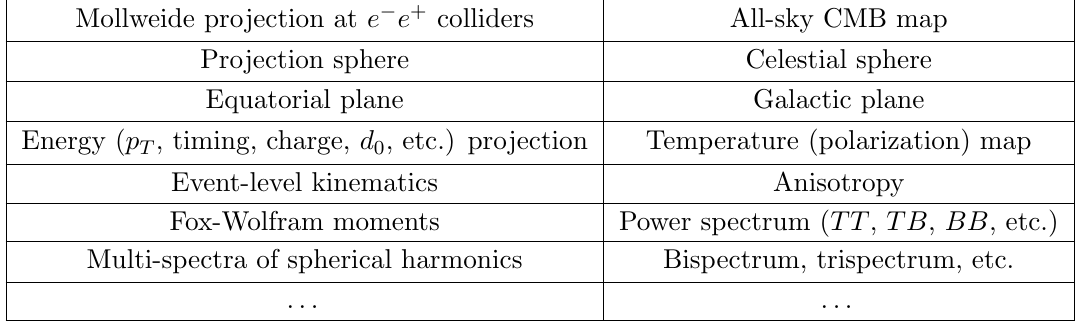
its non-Gaussian e(cid:11)ects being expected to be tiny. In contrast, the Mollweide projection of each event at e (cid:0) e + colliders is physically non-Gaussian. Its multi-spectra thus may contain signi(cid:12)cant information beyond the FW moments on the event-level kinematics. 6 Second, the CMB power spectrum is measured in the universe where we live and hence one realization of all the possible CMBs is recorded only. This limits its measurement precision at large angular scale, causing the notorious \cosmic variance" problem. Di(cid:11)erently, the collider data sample is typically of large size. The variance of their mean over samples are suppressed for the FW moments at all multipoles, according to the central limit